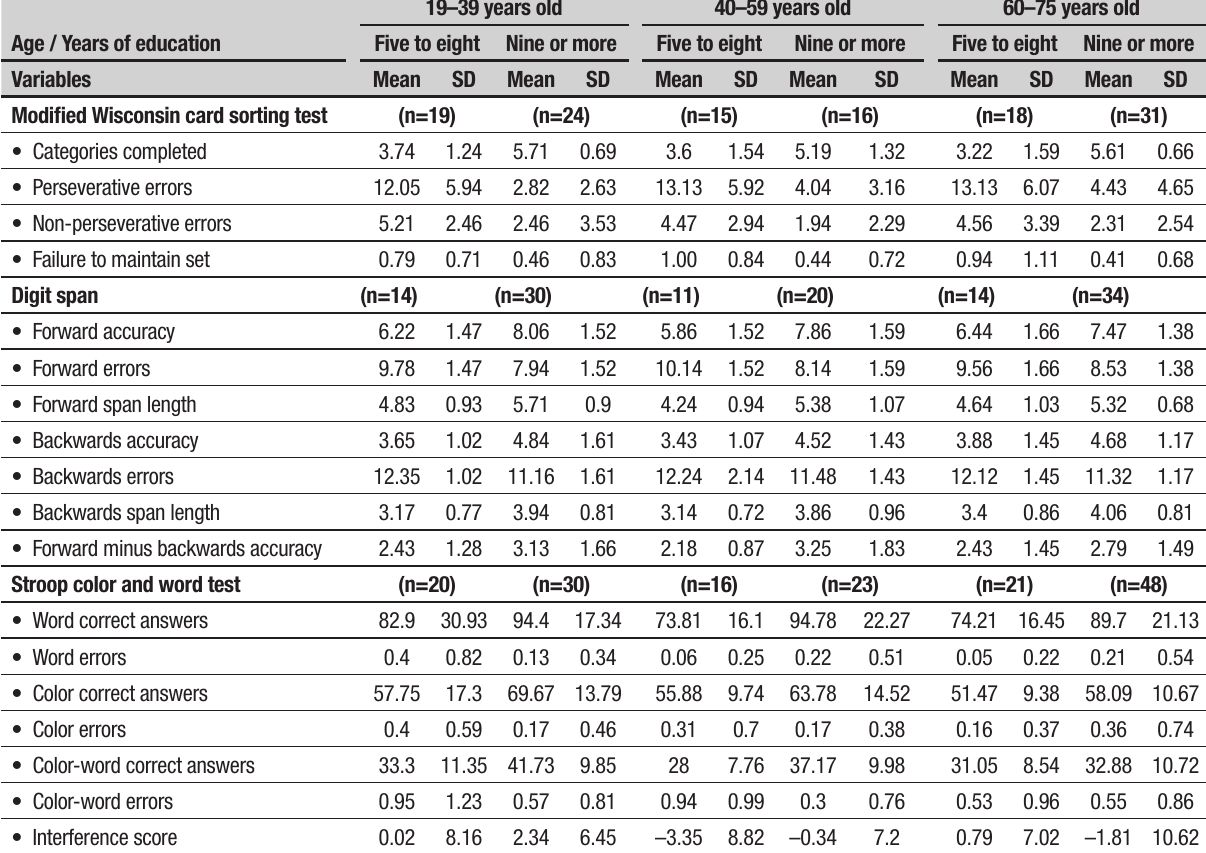
Table 4. Means and standard deviation data for performance on MWCST, Digit span and Stroop color and word test. Age / Years of